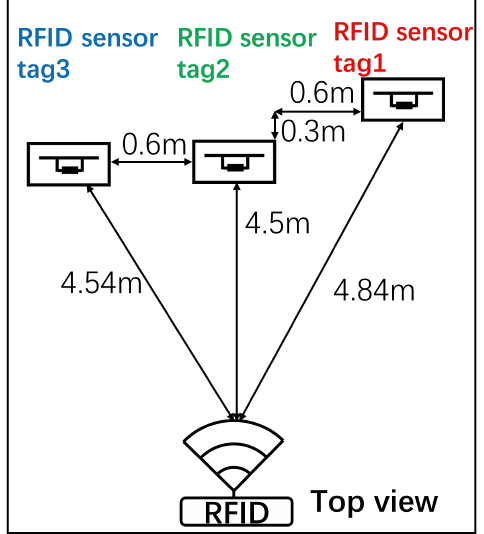
Figure 6. The top view and the reading distances between the RFID reader and RFID sensor tags.